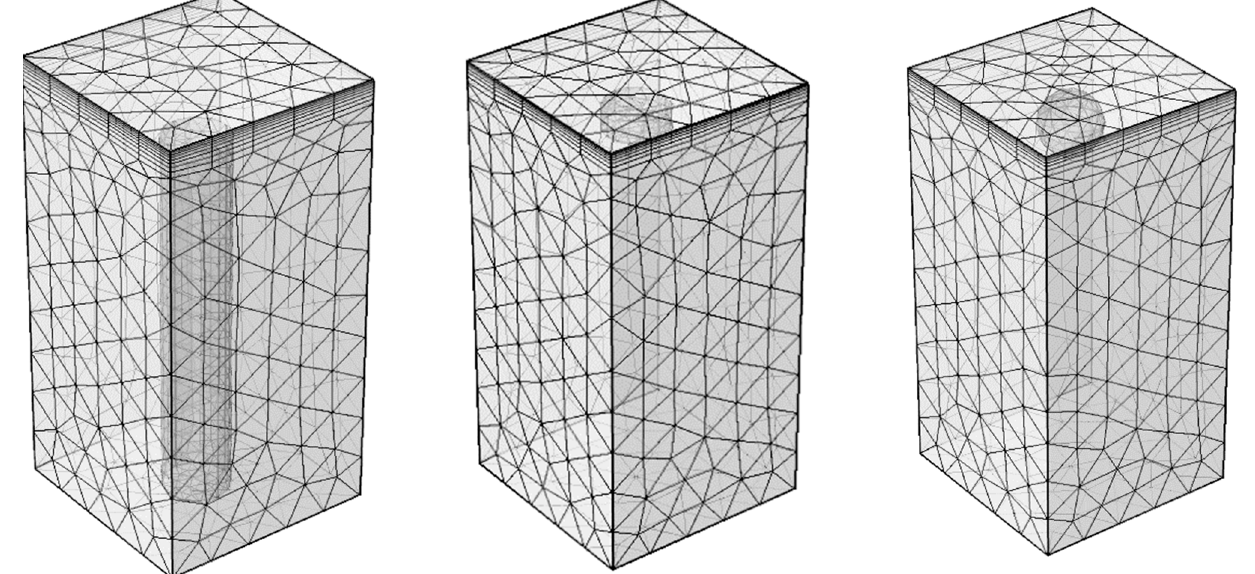
Figure 3. Examples of finite element mesh in Comsol Multyphisics (from left to right: FBH, disk, sphere).